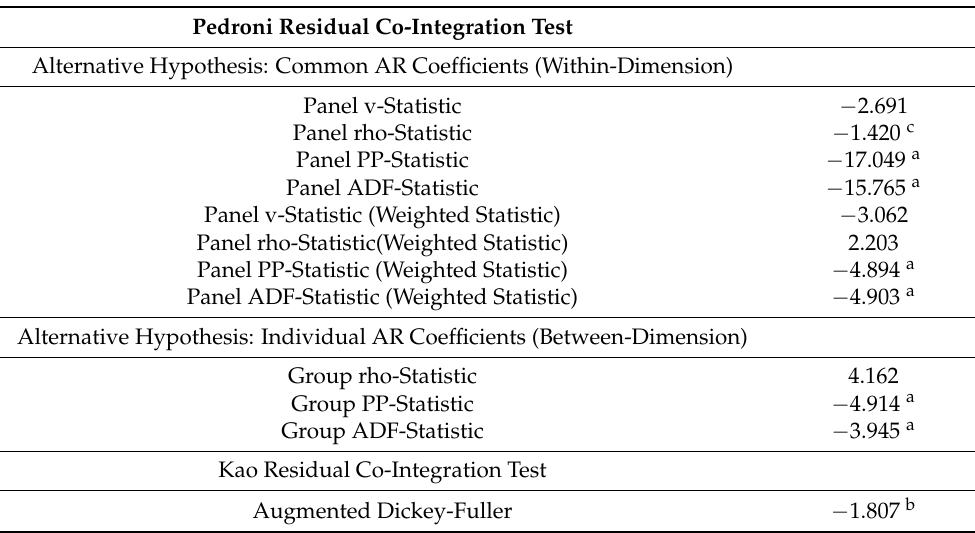
Table 6. Panel co-integration test outcomes.